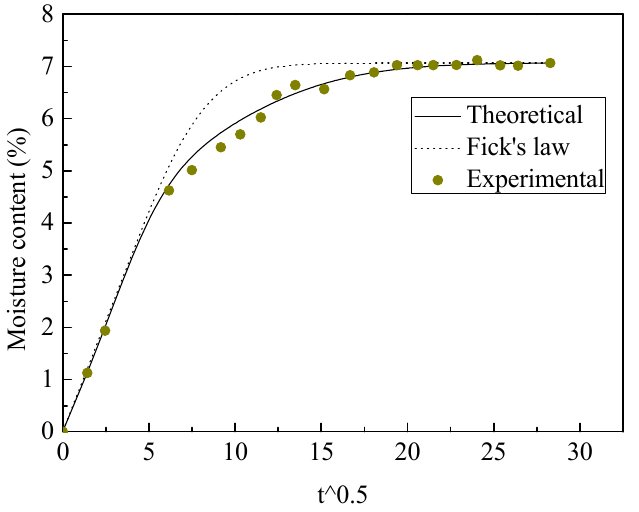
Figure 13. The experimental and theoretical moisture diffusion results for composite b.